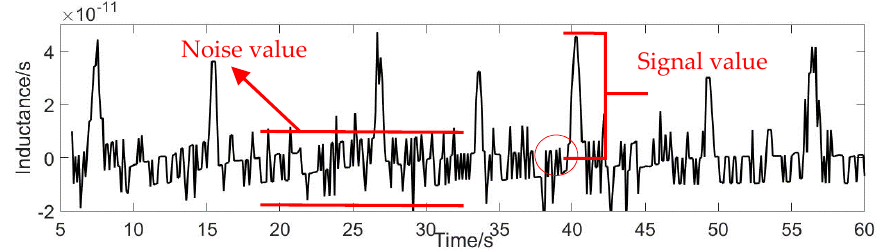
Figure 10. Signal value and noise value schematic diagram.